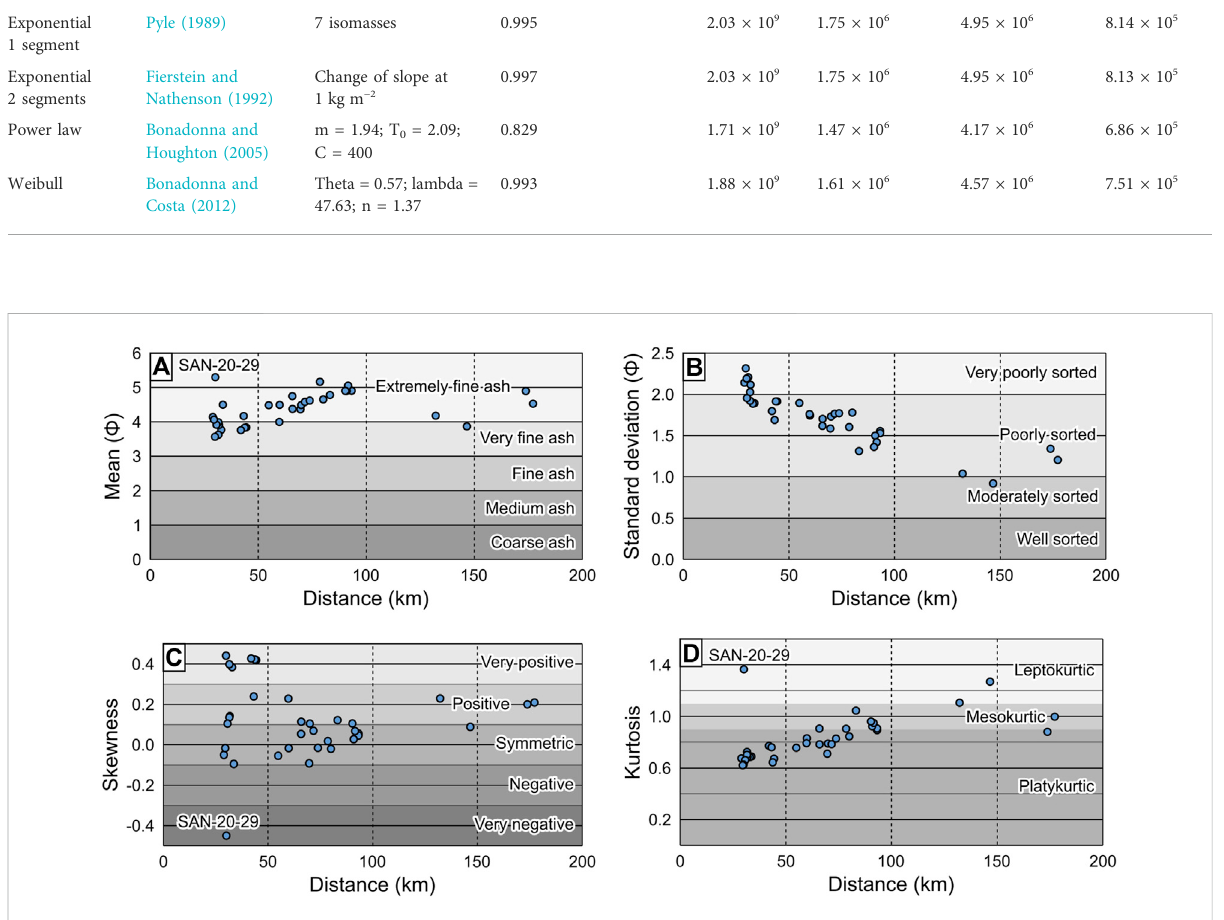
FIGURE 6 Graphical statistics (Folk and Ward, 1957) of grain size distributions of samples from the September 20, 2020 eruptive pulse relative to their distance from Sangay volcano. (A) Mean ( φ ); (B) Standard deviation ( φ ); (C) Skewness; (D)